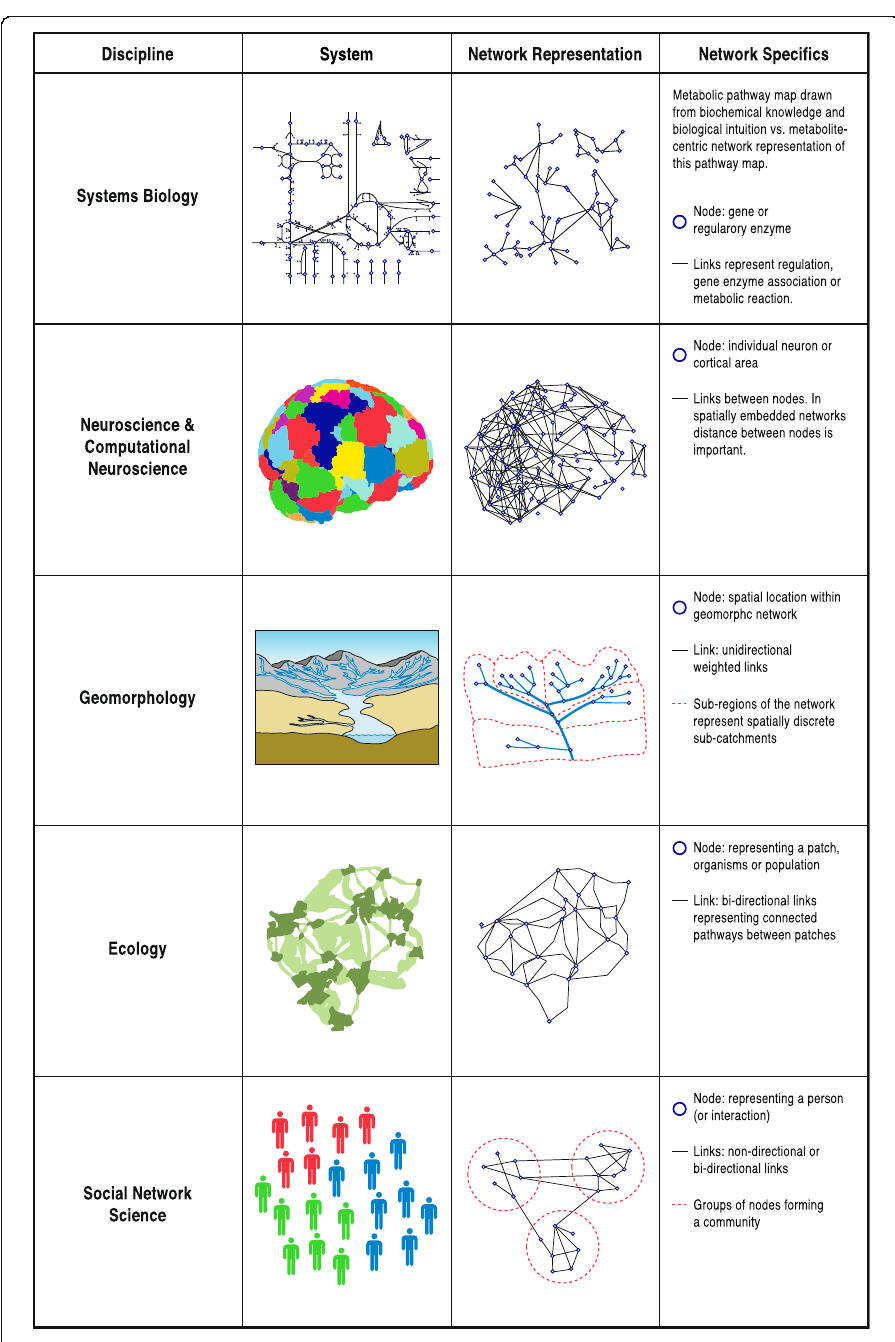
Fig. 1 Network-based representation of structural and functional connectivity. Illustration of ways in which structural and functional connectivity within a multitude of systems can be conceptualised using a network-based approach across Systems Biology, Neuroscience/Computational Neuroscience, Geomorphology, Ecology, and Social Network